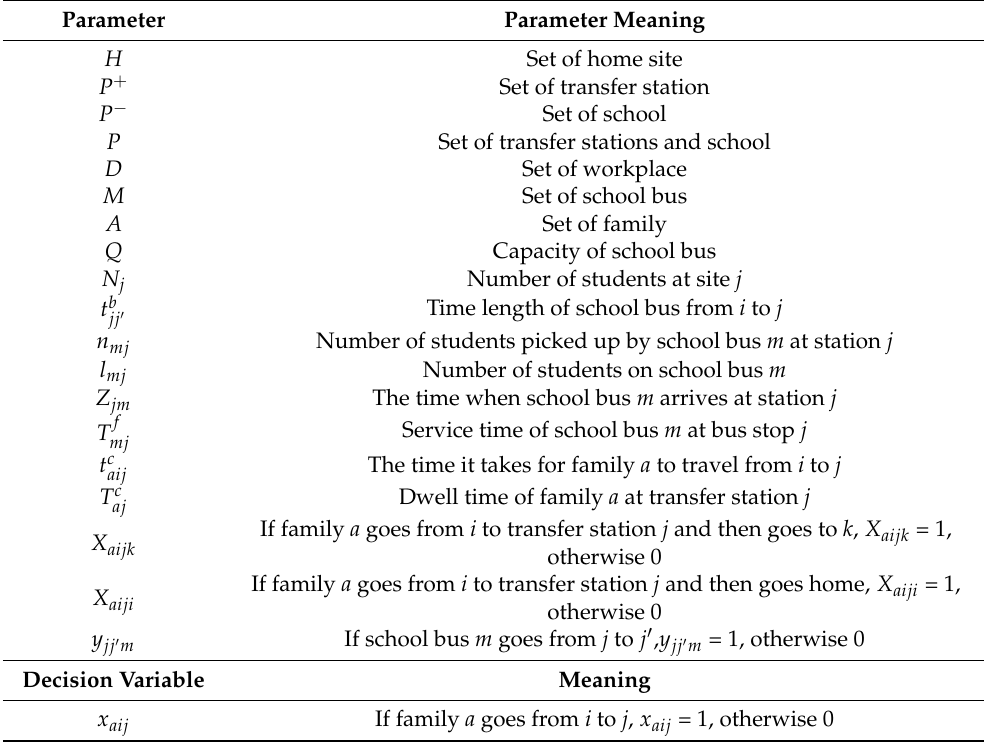
Table 1. The parameters and decision variables in the mathematical model.